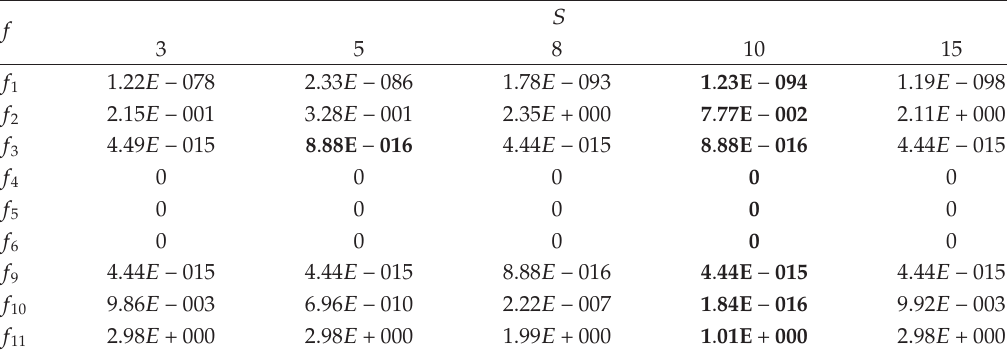
Table 2: Parameter tuning of subswarm size (cid:2) S (cid:3) .